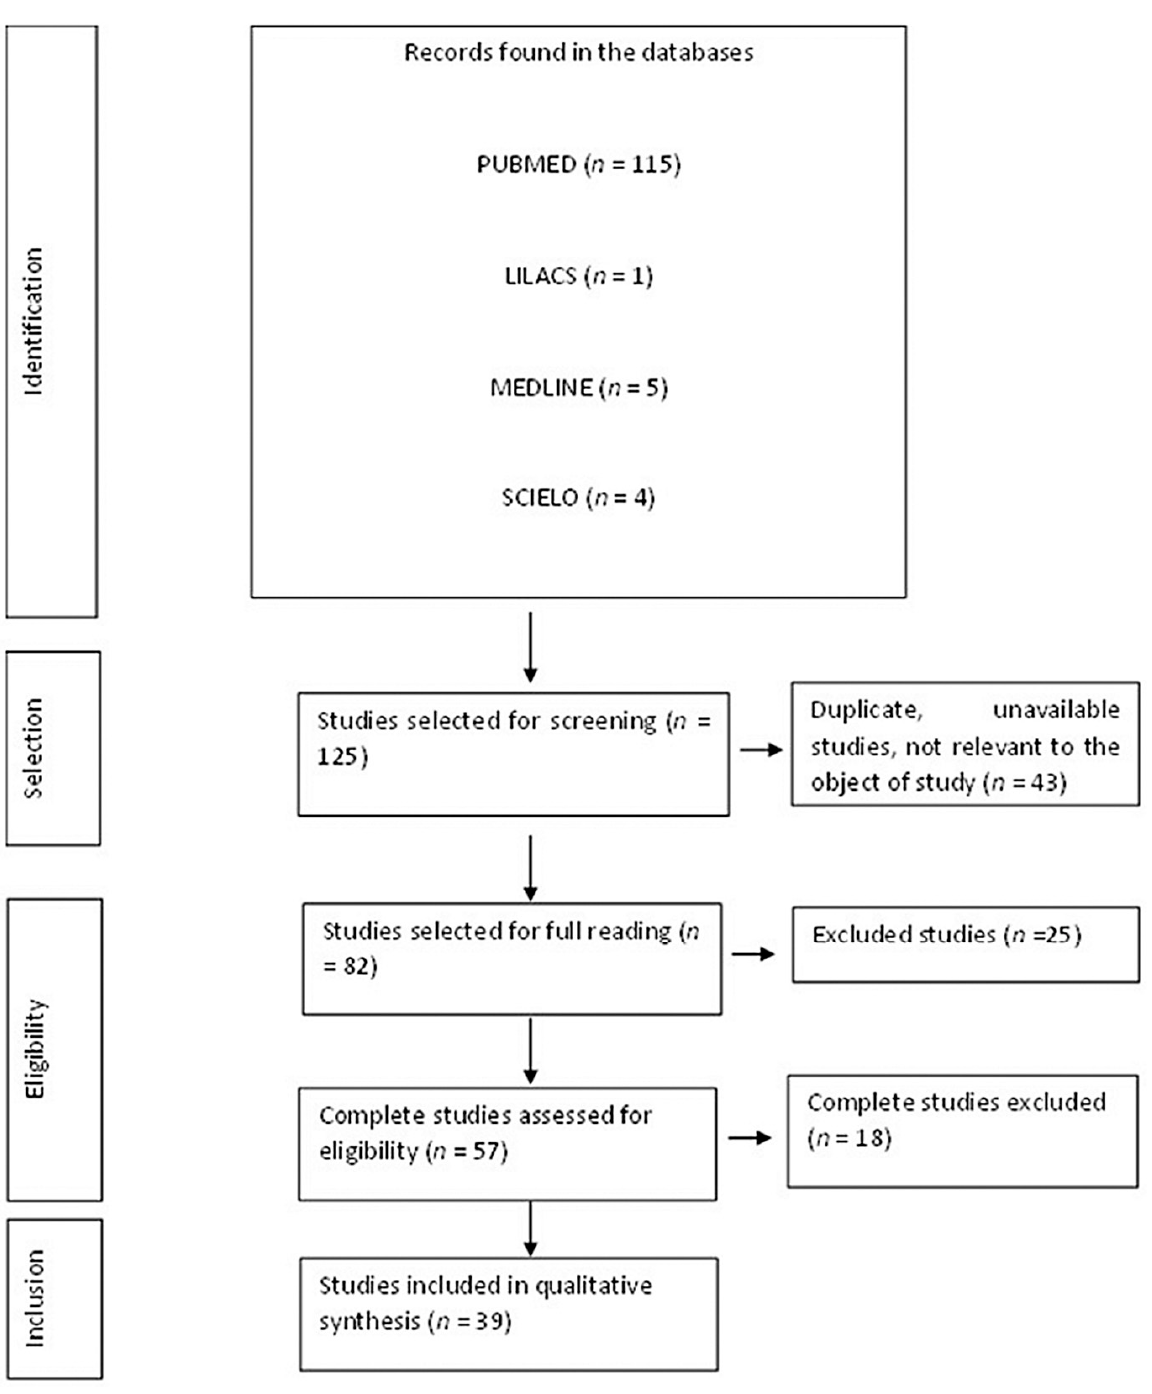
Figure 1. Flowchart of the procedures for the identification, selection, eligibility, and inclusion of studies for analysis. Belém, PA, Brazil (2022).